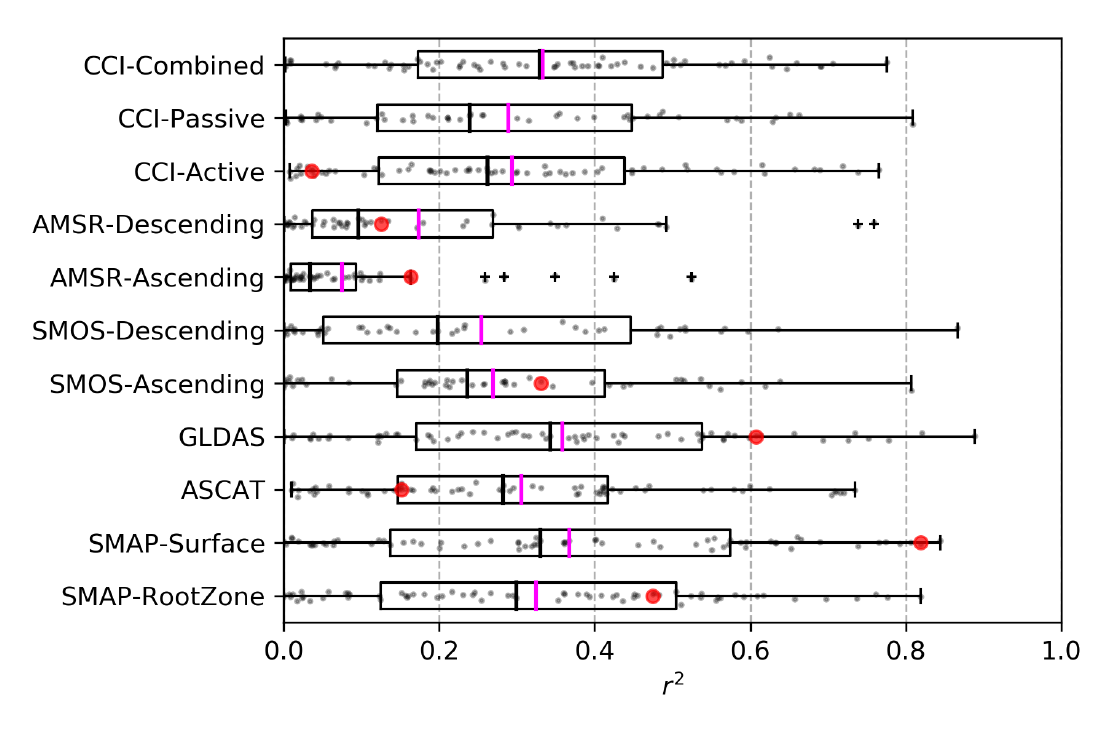
Figure 5. Box and whisker plots showing r 2 values between the satellite products and the CRNP’s in the COSMOS database. Red points show the results for Çakıt Basin CRNP, pink lines show the mean values and + signs depict